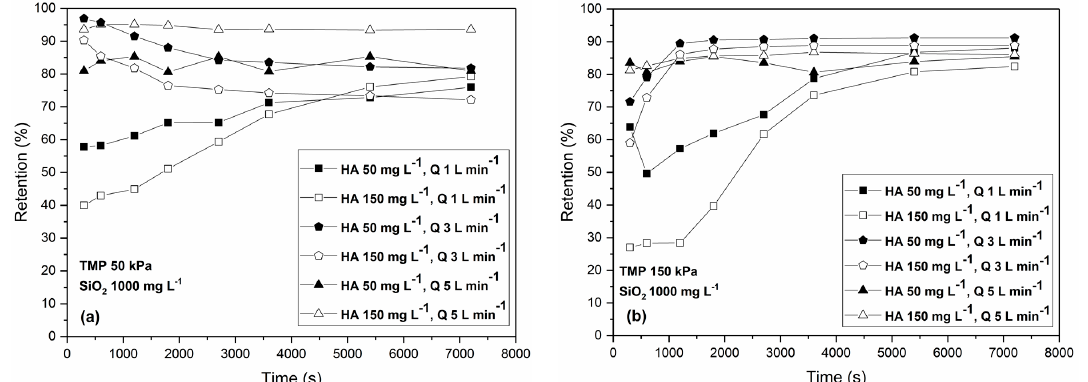
Figure 9. Time dependency of retention of humic acid during the ultrafiltration of the mixture of humic acid and colloidal silica under different operating conditions: ( a ) transmembrane pressure of 50 kPa and ( b ) transmembrane pressure of 150 kPa. The concentrations of humic acid (50 and 150 mg L − 1 ) and cross-flow rates (1, 3, and 5 L min − 1 ) are varied. The concentration of colloidal silica was constant (1000 mg L − 1 ).